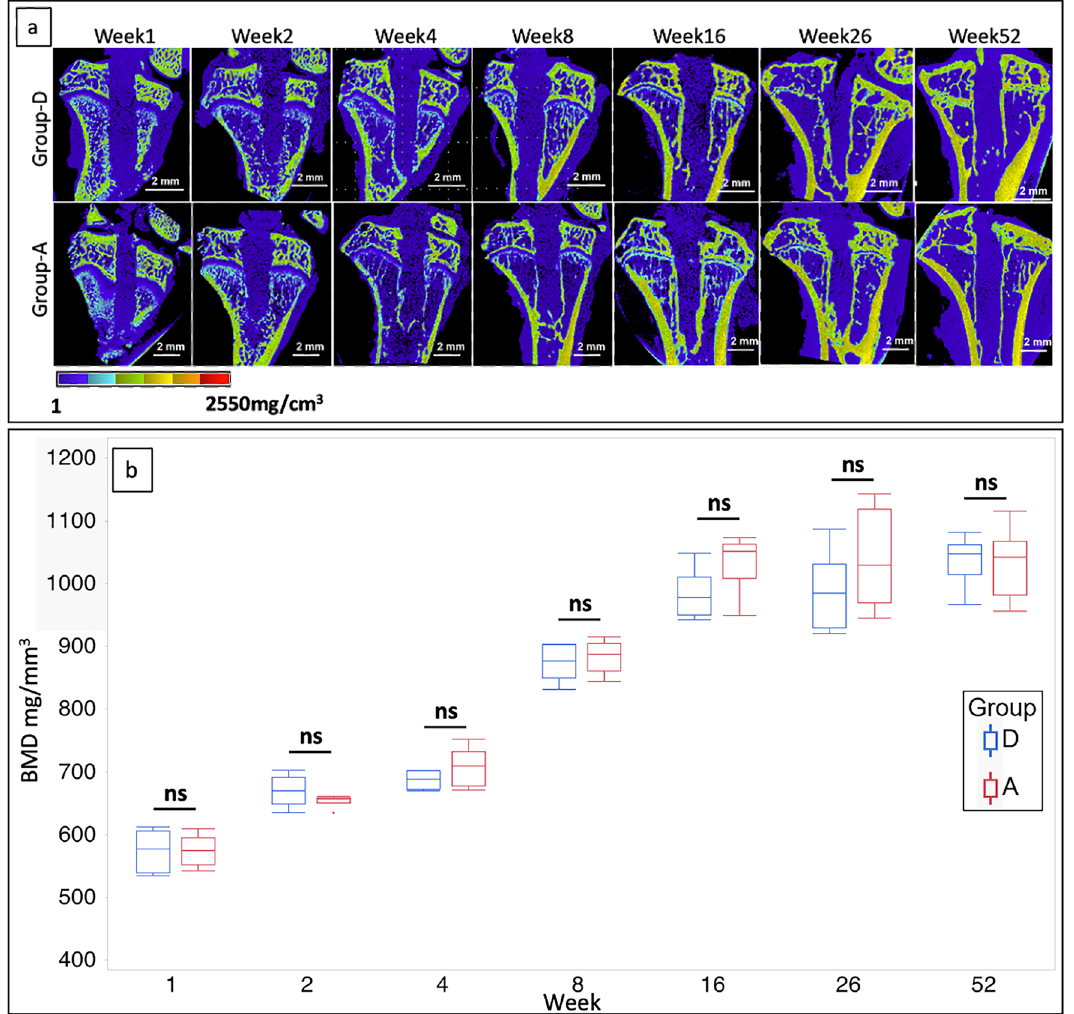
Figure 2. Time-series analysis of BMD at the interface between graft and peritibial bone tunnel. ( a ) Micro-CT images of slices parallel to the tibial tunnel at each time point in each group. ( b ) Box plots showing the BMD of the peritibial tunnel for each group at each time point. (n = 6, for each period in each group). BMD bone mineral density, CT computed tomography, group D decellularized bovine tendon graft, group A autologous tendon graft, ns not statistically